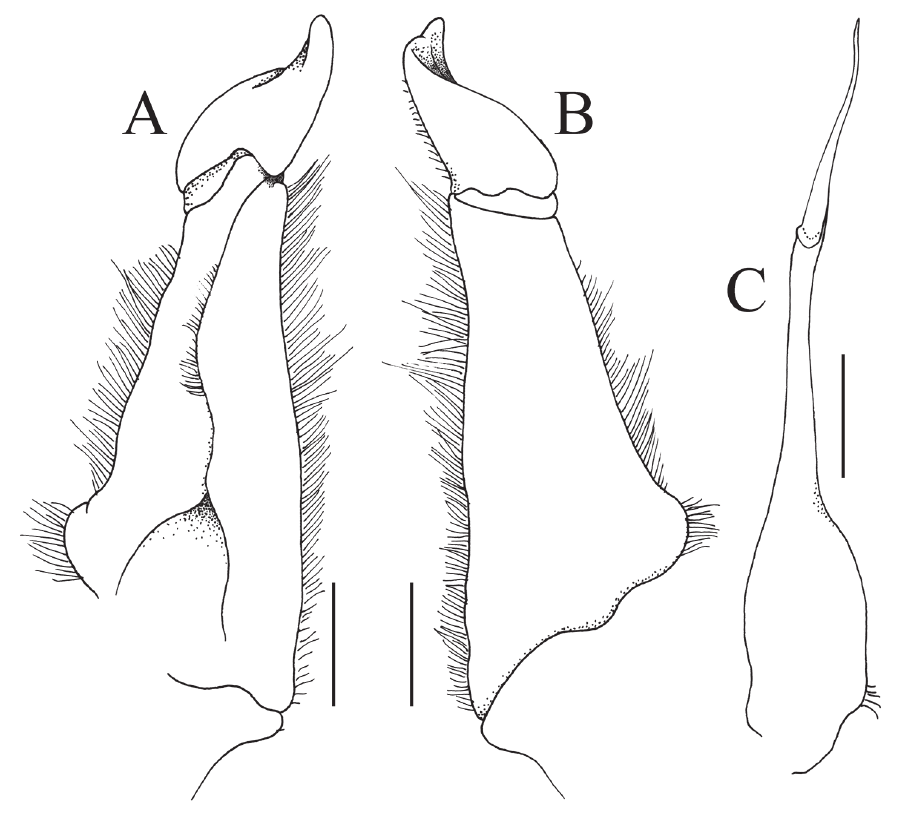
Figure 7. Salangathelphusa anophrys (Kemp, 1923), male (26.9 × 20.7 mm) (ZRC 1989.2011), Trang, Thailand. A left G1 (ventral view) B left G1 (dorsal view) C left G2. Scale bars 1.0